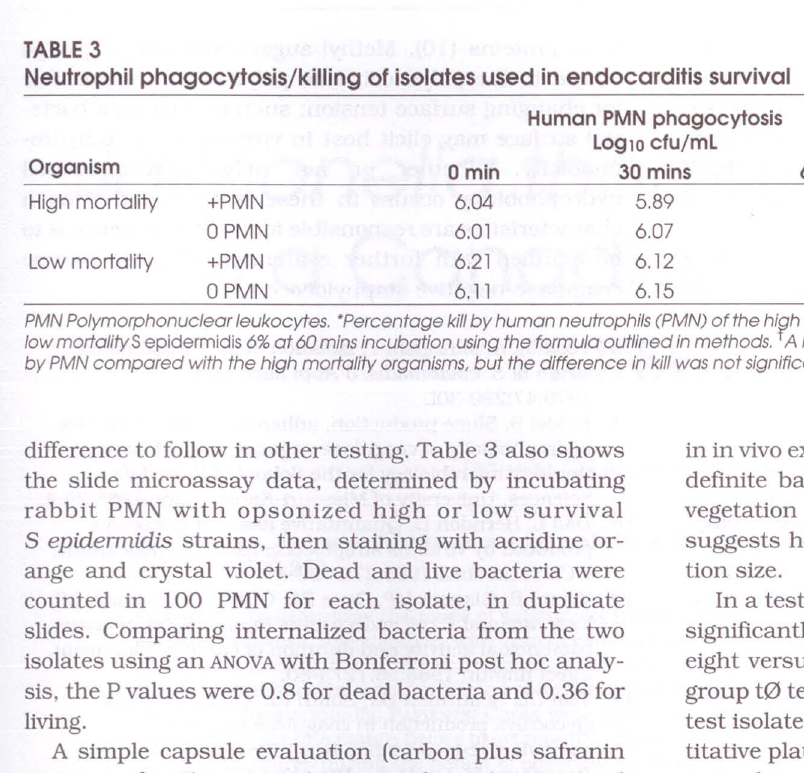
Neutrophil phagocytosis/killing of isolates used in endocarditis